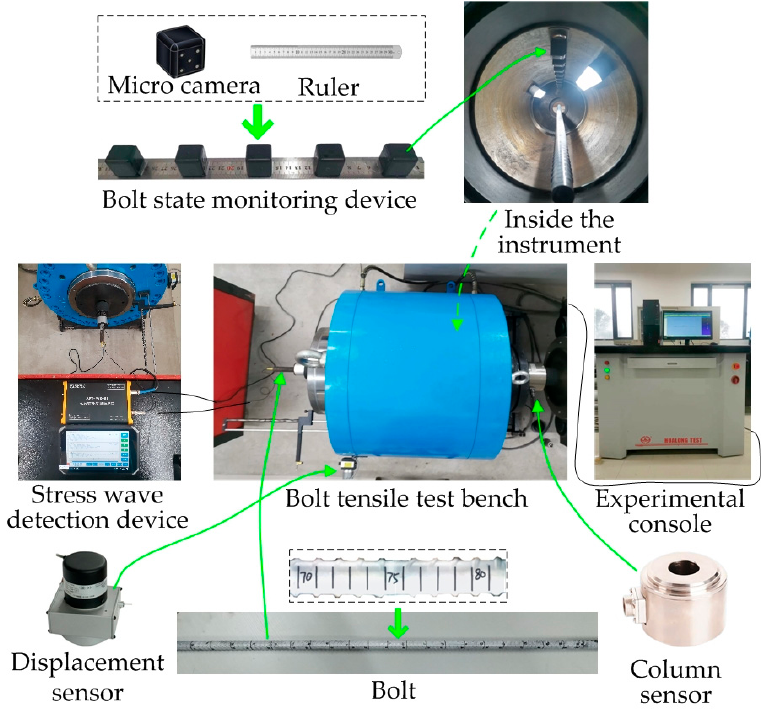
Figure 1. Bolt tensile and stress wave detection test system.